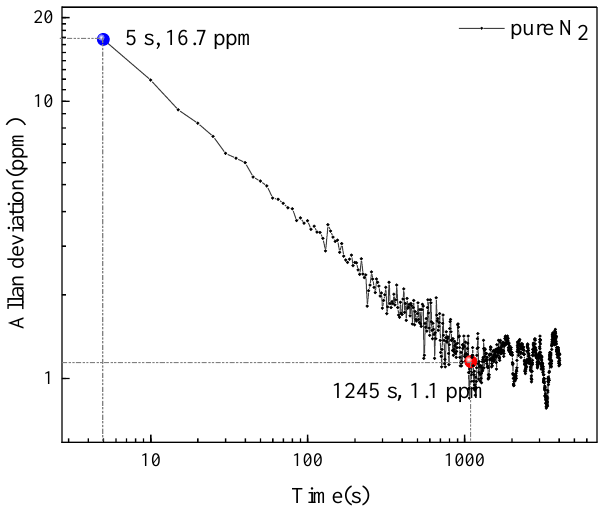
Figure 8. Allan – Werle deviation at 760 Torr for detection of N 2 .